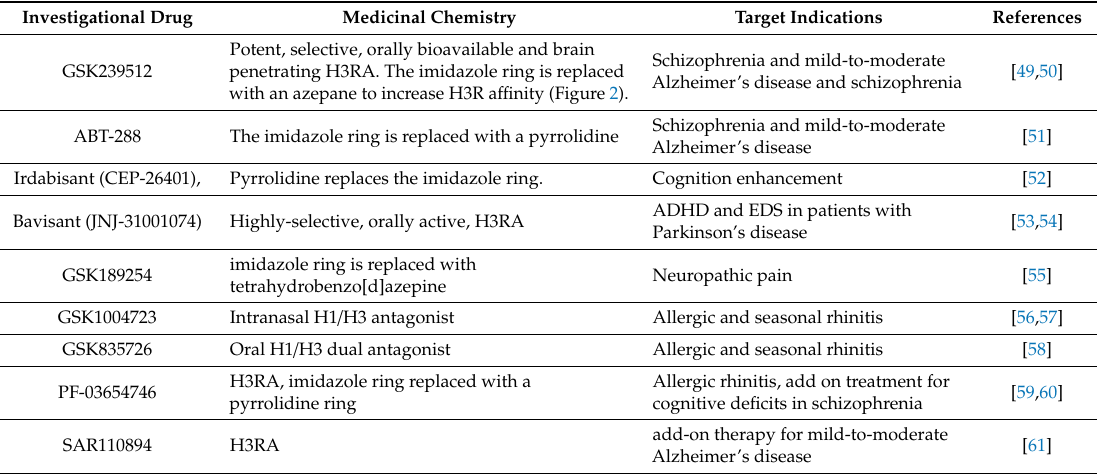
Table 3. Investigational histamine-3 receptor antagonists currently in various stages of clinical